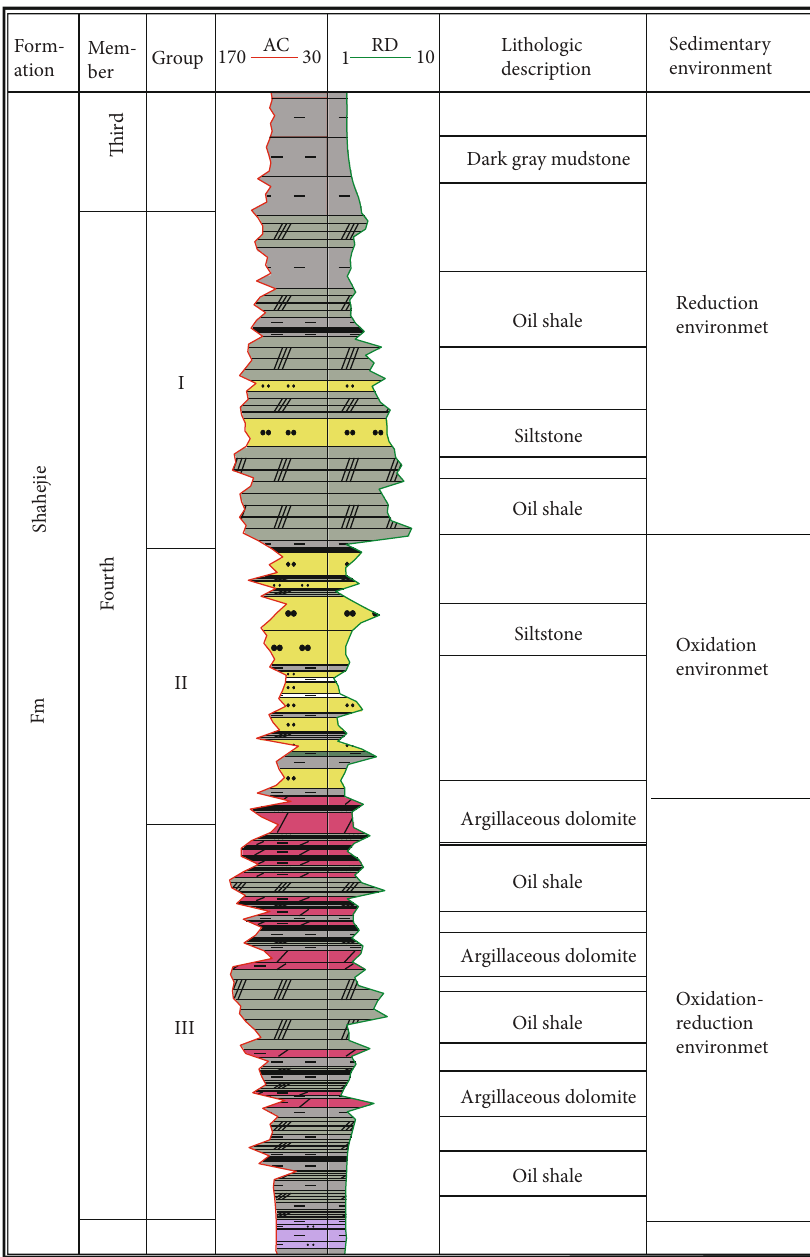
Figure 3: Geological section of E